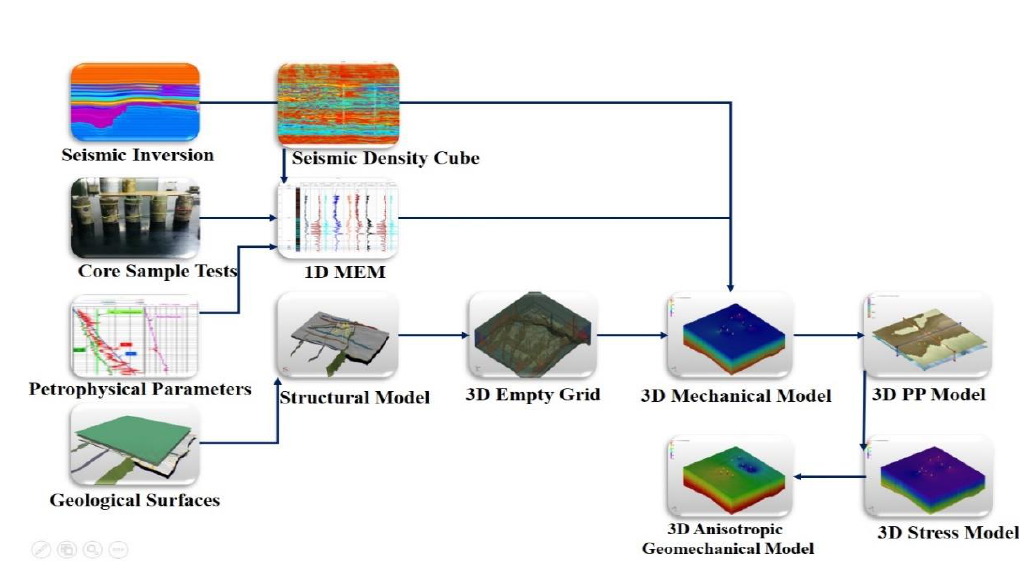
Figure 4. A detailed integrated workflow for developing 1D and 3D geomechanical